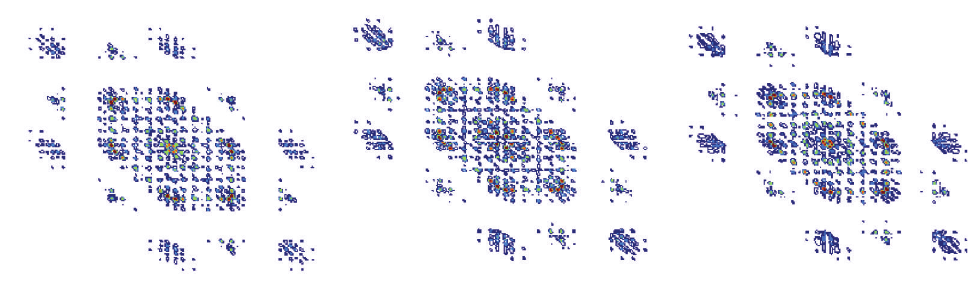
Figure 9: Bispectrum contour map of fault 1.